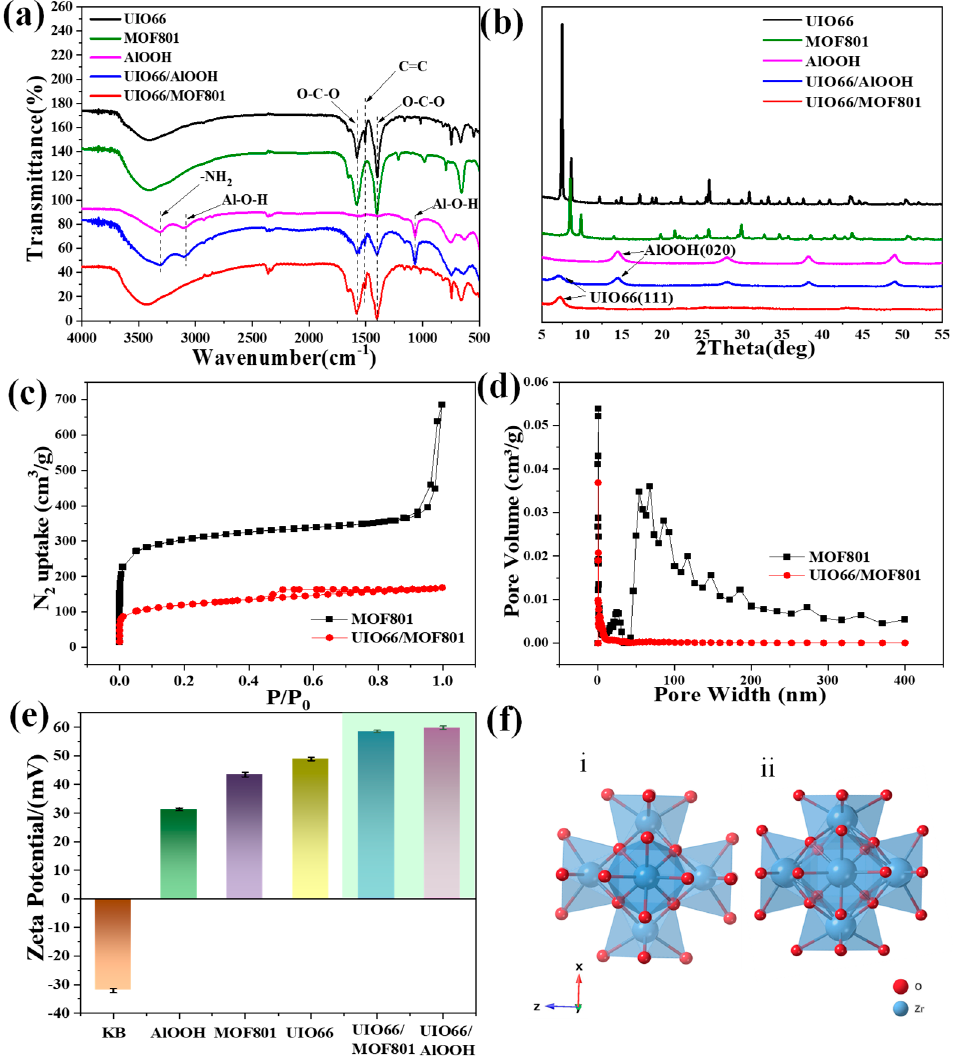
Figure 2. ( a ) FTIR spectra and ( b ) XRD patterns of UIO66, AlOOH, MOF801, UIO66/AlOOH and UIO66/MOF801 nanomaterials; ( c ) N 2 adsorption-desorption isotherms and ( d ) Pore size distribution curves of MOF801 and UIO66/MOF801; ( e ) Zeta potentials of UIO66, AlOOH, MOF801, UIO66/AlOOH and UIO66/MOF801 nanomaterials; ( f ) The inner core Zr 6 -cluster structure of (i) UIO66 and (ii) MOF801. Zr, blue; O, red.